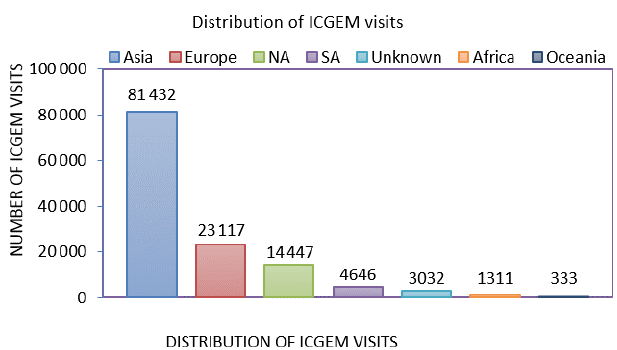
Figure 2. Distribution of ICGEM visits over continents between May 2018 and December 2018. NA is for North America, SA is for South America, and unknown is for anonymous